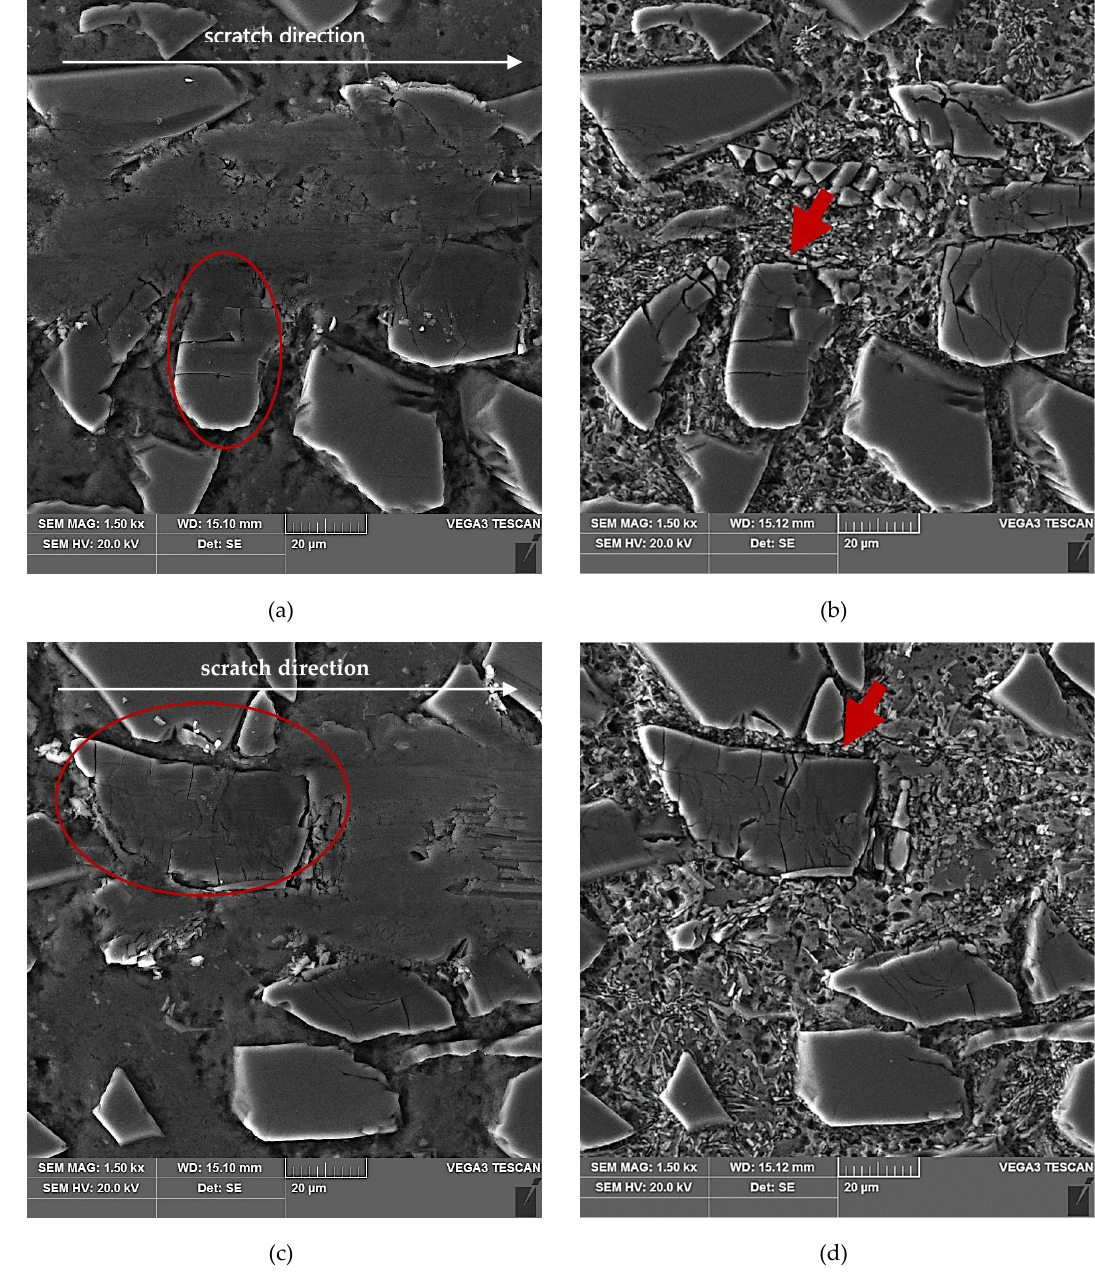
Figure 11. SEM images of a scratch made by the diamond indenter loaded with a force of 2.5 N in the AlSi12/SiC p composite layer area: ( a ) and ( c ) matrix smearing and particles cracking are visible; section etched with 20% NaOH solution for 2 s; ( b ) degradation of the SiC particle oriented perpendicular to the scratch direction has been marked with a red arrow; section etched with 20% NaOH solution for 60 s (deep etching); ( d ) degradation of the SiC particle oriented parallel to the scratch direction has been marked with a red arrow; section etched with 20% NaOH solution for 60 s (deep etching).